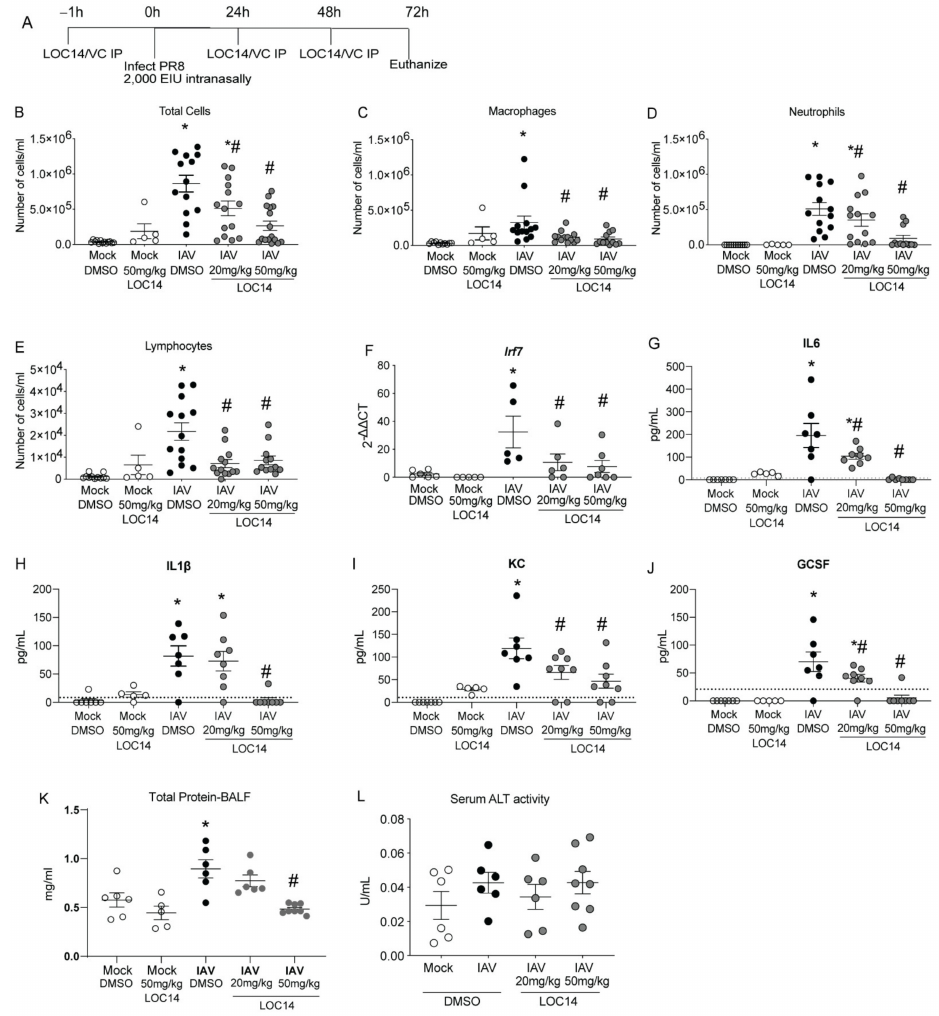
Figure 3. LOC14 treatment decreases influenza-induced inflammatory response in mice. ( A ) Schematic representing the time points of IAV infection and LOC14 treatment and euthanasia of mice (IP- intraperitoneal injection). ( B – J ) Analysis of inflammatory cells by flow cytometry, mRNA for Irf7 in whole lung lysate by RT-qPCR, and ELISA for inflammatory cytokines and chemokines from BAL fluid of infected mice. ( K , L ) Analysis of total protein in BALF and serum ALT in influenza or mock-infected mice treated with LOC14. * p < 0.05 compared to mock groups, # p < 0.05 compared to IAV-DMSO group by two-way ANOVA. Data are expressed as the standard error of the mean ( ±